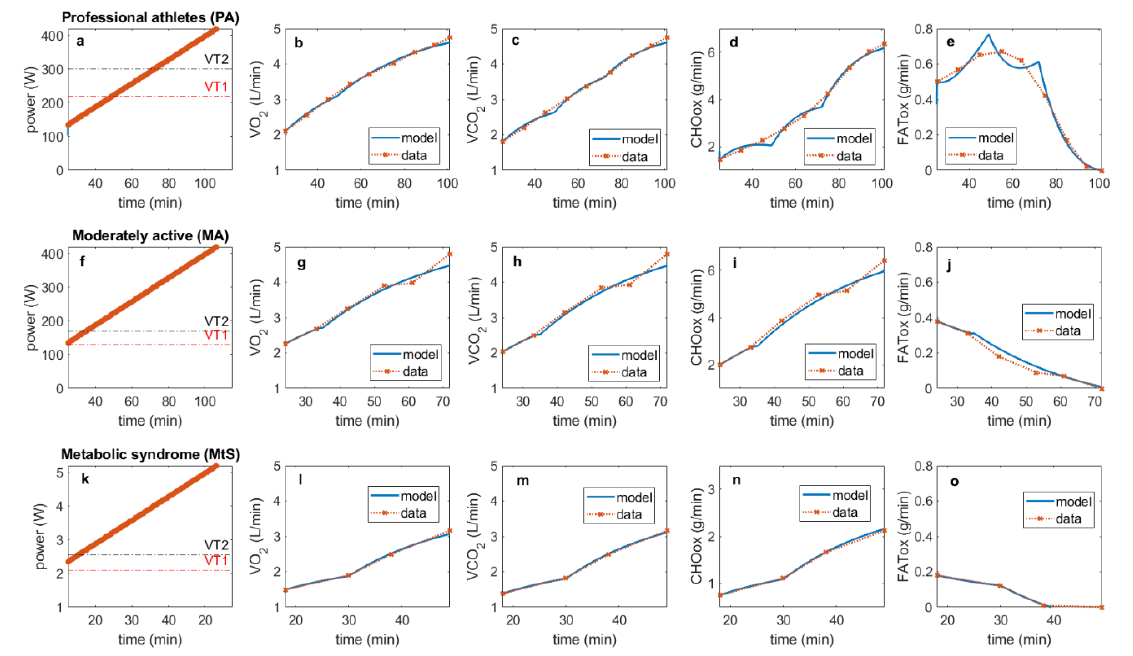
Figure 2. Simulation of experimentally observed relationship between exercise intensity for profes- sional athletes (top row), moderately active individuals (middle row), and individuals with metabolic syndrome (bottom row). ( a , f , k ) A simulation of exercise, increasing by 35W every ten minutes starting from time t =10 min, with simulations in figures reported from time t = 25 min due to the format of collected data for PA, MA and MtS respectively; ( b , g , l ) calculated VO 2 for PA, MA and MtS respectively; ( c , h , m ) calculated VCO 2 for PA, MA and MtS respectively; ( d , i , n ) oxidized carbohydrates CHOox for PA, MA and MtS respectively; ( e , j , o ) oxidized fatty acids FATox for PA, MA and MtS respectively.